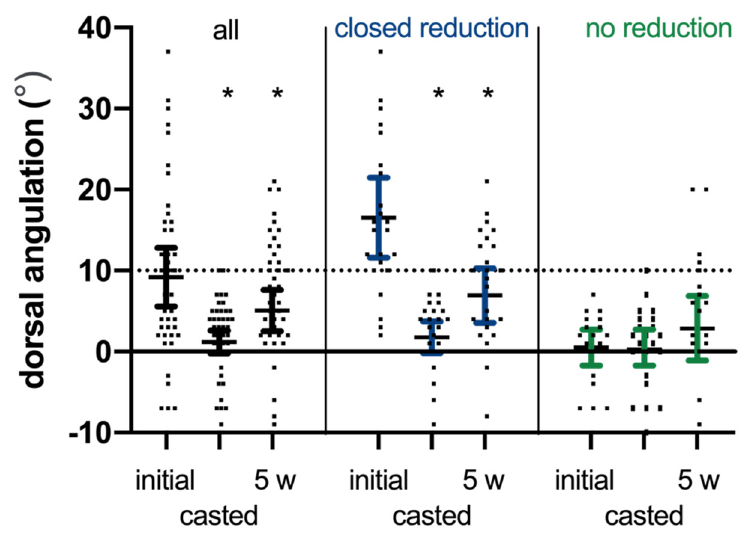
Figure 4. Dorsal angulation of the DRF at presentation, i.e., initial radiograph, the casted radiograph, and the final radiograph after five weeks (5 w) for all DRF and subdivided based on closed reduction (yes; no). * p < 0.05 compared with the initial dorsal angulation.